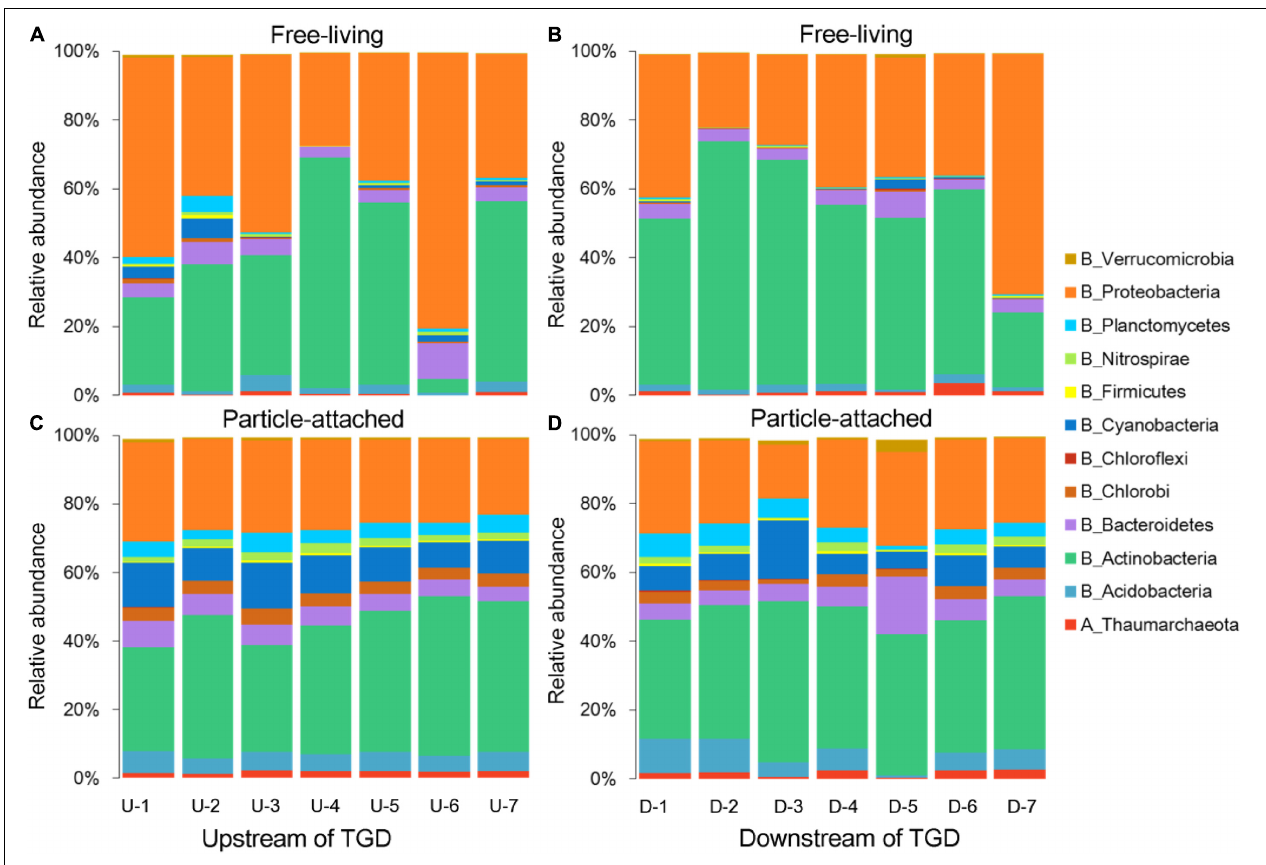
FIGURE 1 | Taxonomic compositions for free-living (A,B) and particle-attached (C,D) communities upstream and downstream of the Three Gorges Dam (TGD),